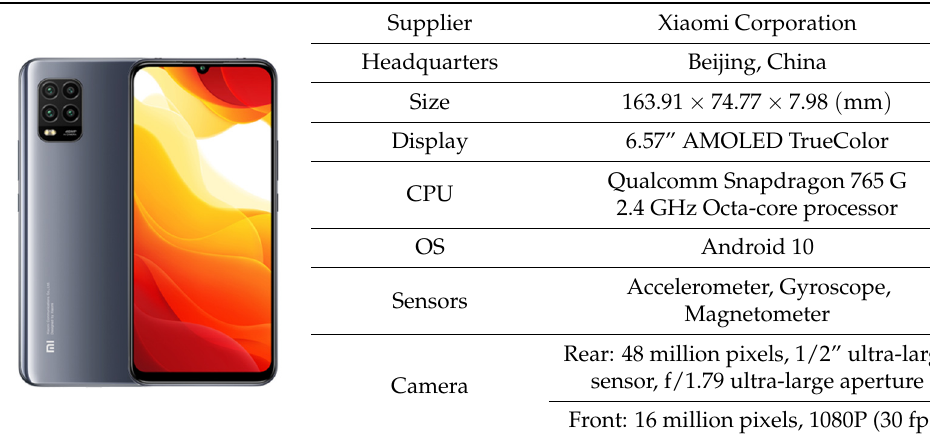
Sensors 2022 , 22 , x FOR PEER REVIEW